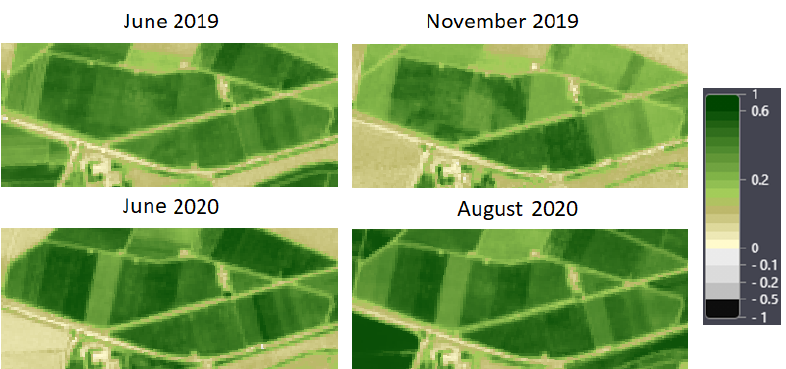
Figure 12. SAVI index evolution in stone fruit tree exploitation.